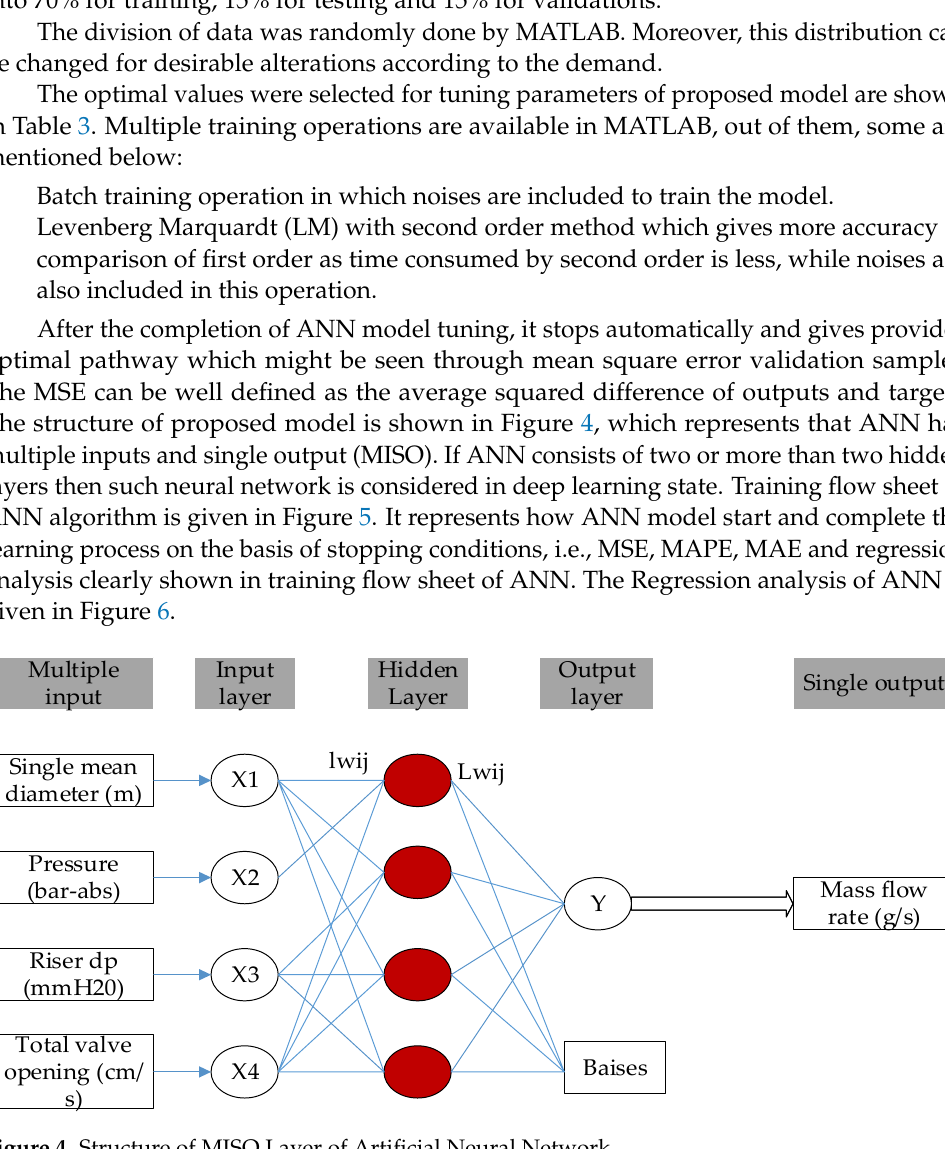
Yes Figure 5. ANN training flow sheet.